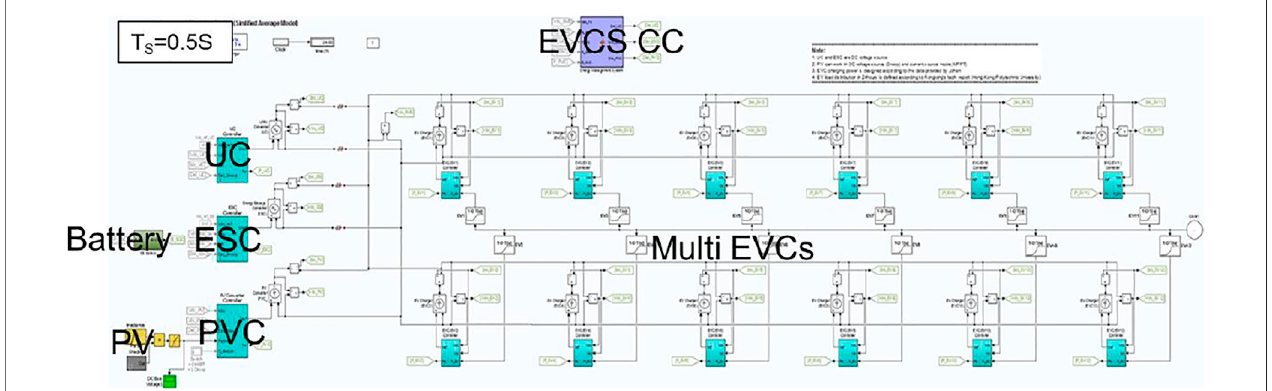
FIGURE 3 | Overview of this integrated electric vehicle charging station (EVCS) simulation